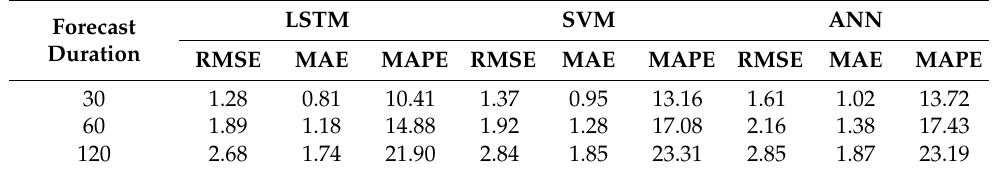
Table 2. Comparison of nowcast results based on different models. Forecast Duration